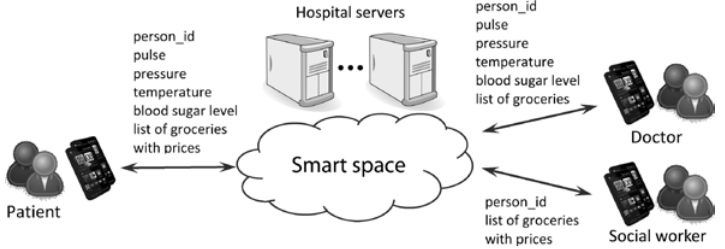
Figure 3: Usage Example Scenario of Information Exchange without Access Control.